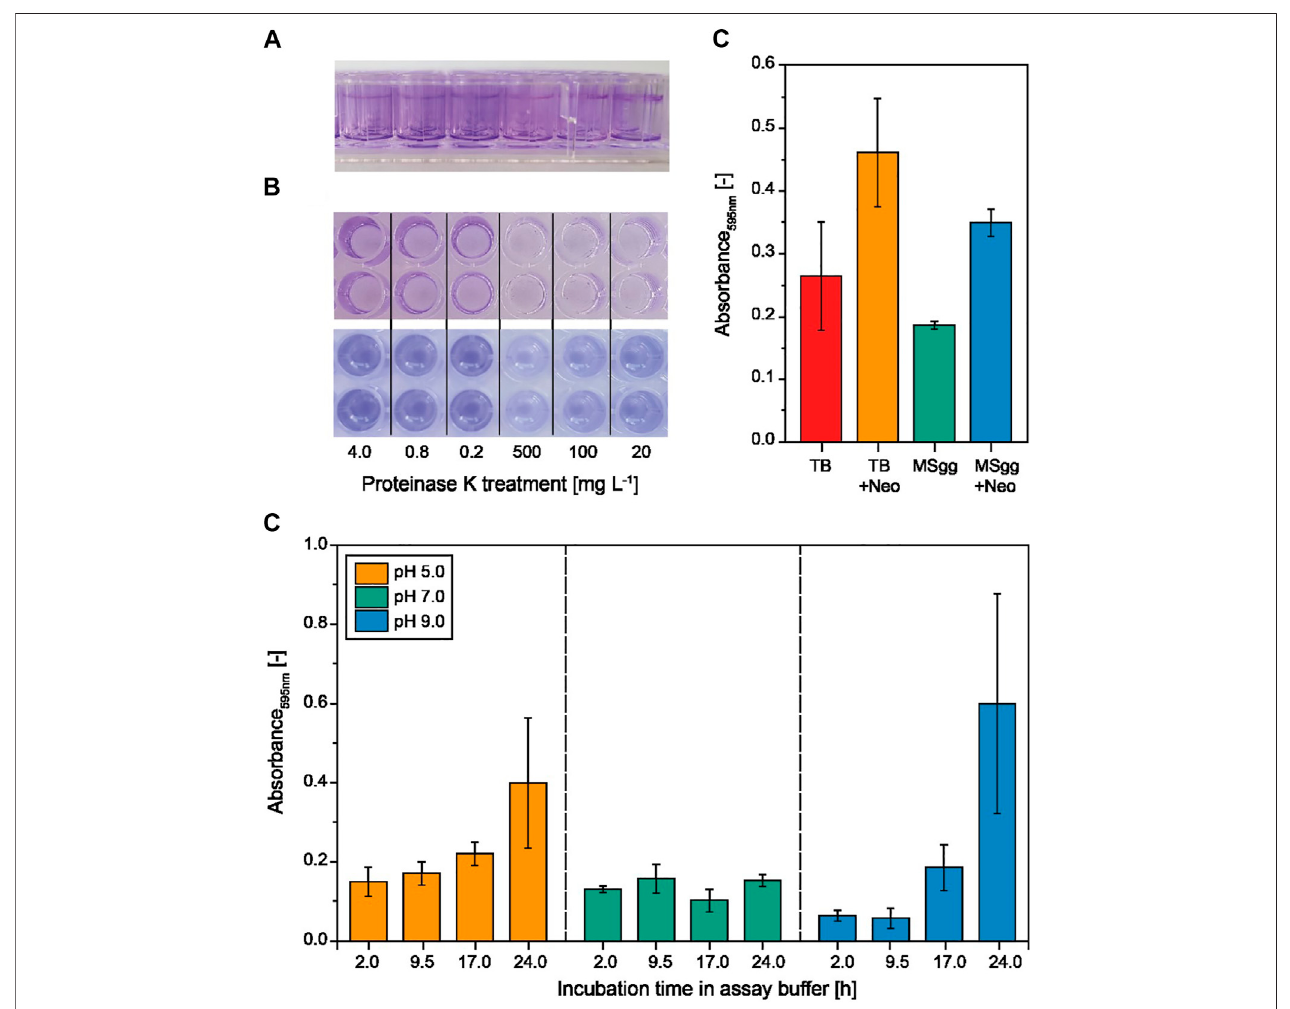
FIGURE 2 | Formation and quanti fi cation of experimental B. subtilis bio fi lms in multiwell plates using different media and assay buffers. (A) Bio fi lms that were submerged (hydrophilic) and formed at the air – liquid interface (hydrophobic) inMSgg (Branda et al., 2001) and TB (not shown) after 24 h were stained with crystal violet. (B) Proteinase K – treated bio fi lms after staining (top) and after re-solubilization (bottom) of crystal violet with acetic acid for quanti fi cation in a plate reader. (C) The crystal violet staining intensity of the bio fi lms formed in MSgg or TB in the presence or absence of neomycin (Neo) measured at 595 nm. Data are means ± standard deviations (n (cid:2) 6 biological replicates). (D) Incubation of preformed (24 h in MSgg) B. subtilis bio fi lms in degradation assay buffer (50 mM TRIS or MES, 5 mM calcium chloride) at different pH values and for different incubation periods (n (cid:2)